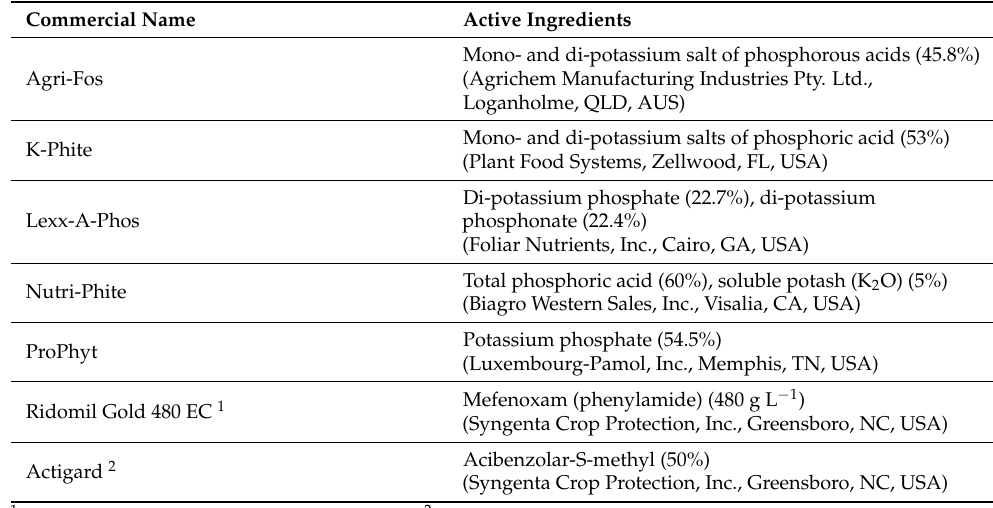
Table 1. Chemicals evaluated in this